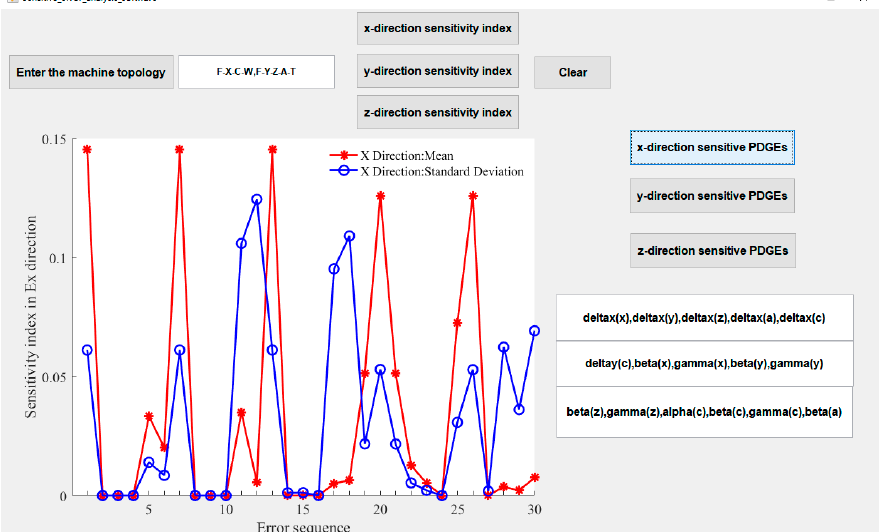
Figure 7. Sensitive PDGEs calculation software.